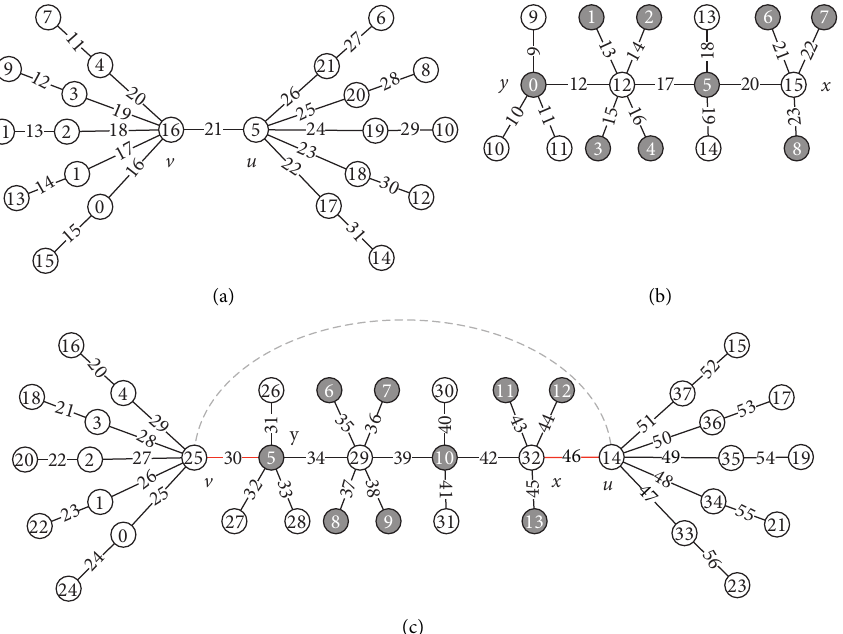
admits a set-ordered strongly c-elegant labelling. (c) An 2